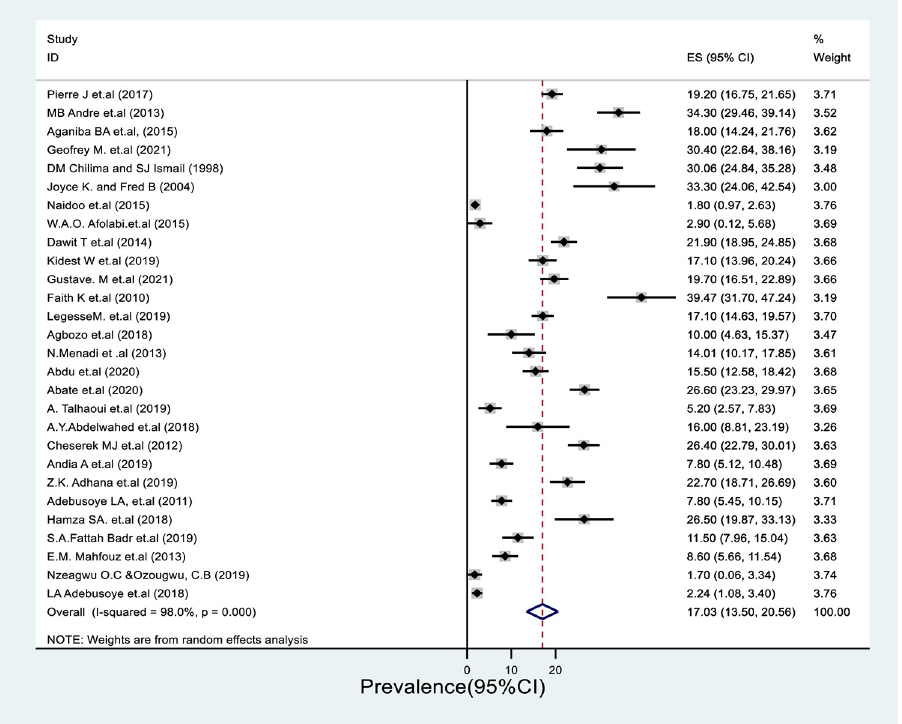
Fig 2. Forest plot of all included studies to assess the pooled prevalence of malnutrition among aged population in Africa.